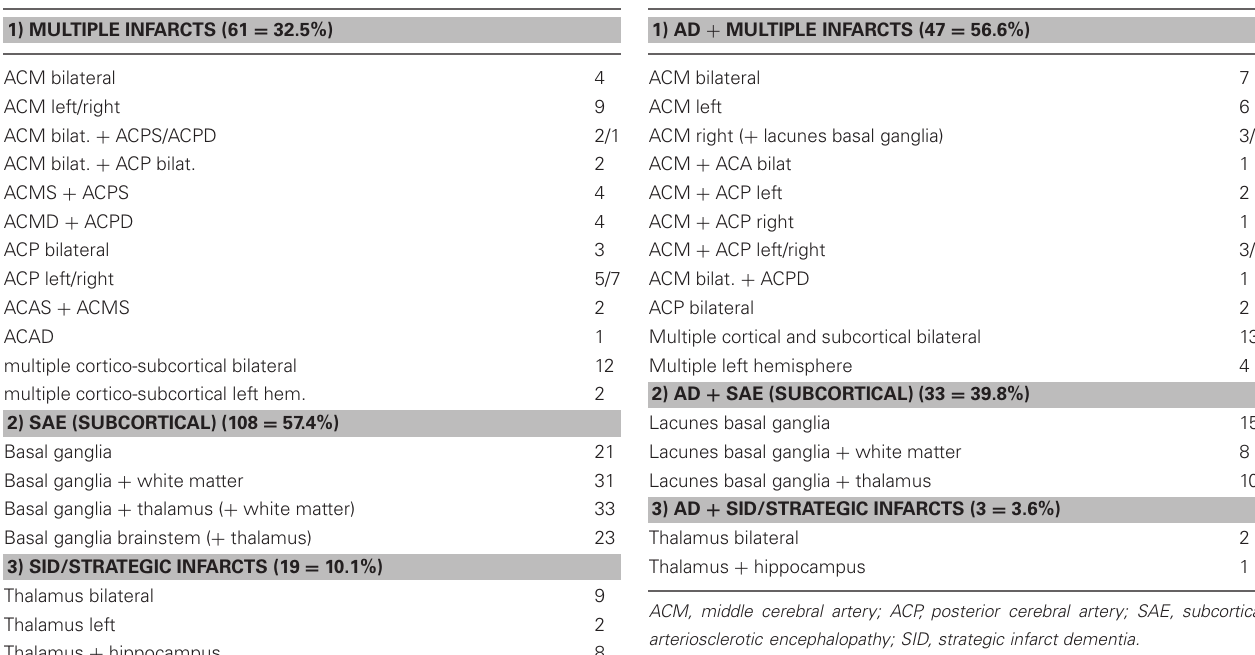
Table 9 | Types and location of cerebrovascular lesions in vascular dementia (total 188, personal series).